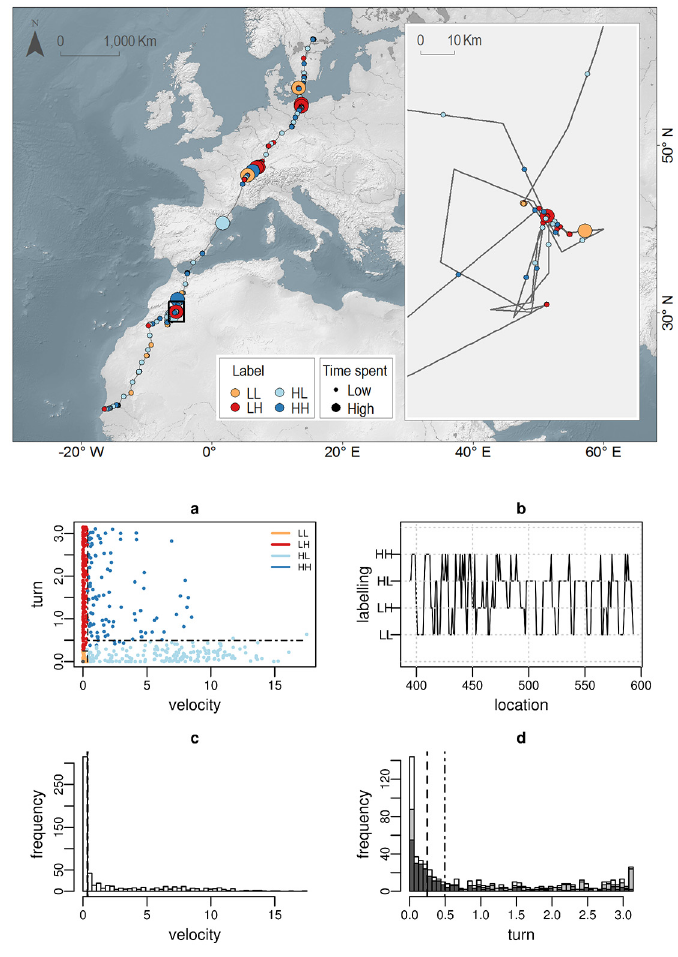
Fig 8. Osprey ( Pandion haliateus ) migratory trajectory. Upper panel: Burst-wise labelled migration trajectory. Symbolization by label (LL:orange, LH:red, HL:cyan, HH:blue) and time spent (symbol size: 2 natural jenks). Scale bar is only approximate. Due to copyright restrictions the figure is for representative purposes only. Source: Made with Natural Earth; Free vector and raster map data @ naturalearthdata.com. Bottom Panels: (a) velocity/turn scatter plot (clustering colour code: LL:orange, LH:red, HL:cyan, HH:blue), (b) temporal behavioural profile (from location 400 to 593) (c) velocity ( m / s ) and (d) turning angle ( rad ) frequency distributions (white colour). The turn distribution for low/high values of velocity is shown separately in light/dark grey colours, respectively. The black lines in panels a, c and d depict the delimiters r . L , r L . (dashed lines) and r . H , r H . (dot-dashed